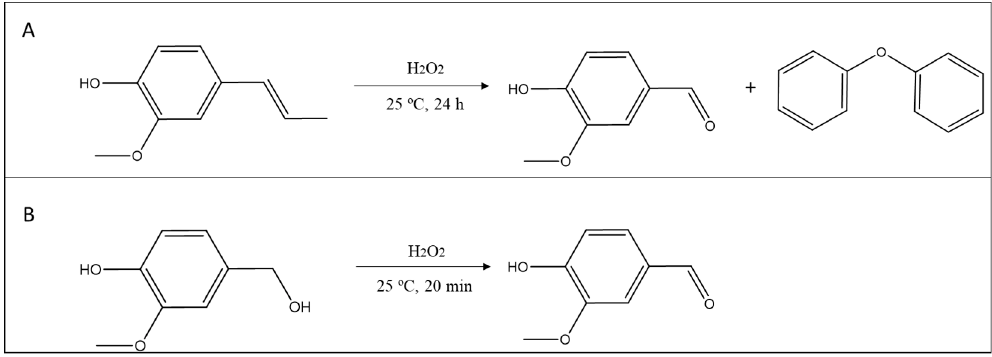
6 of 13 Table 2. Fe/Si atomic ratio obtained by chemical analysis and X-ray photoelectron